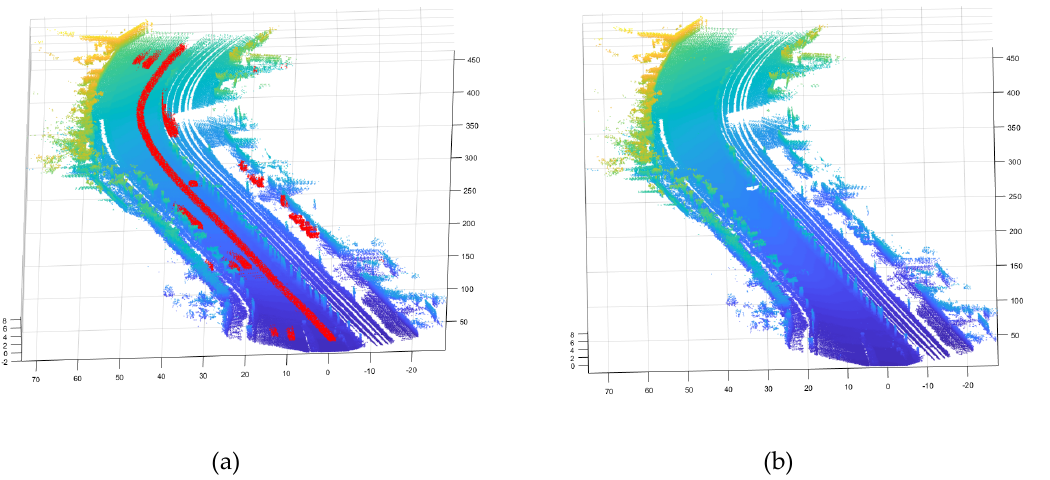
Figure 7. ( a ) Point cloud map with clutter objects, ( b ) Cleared point cloud map.